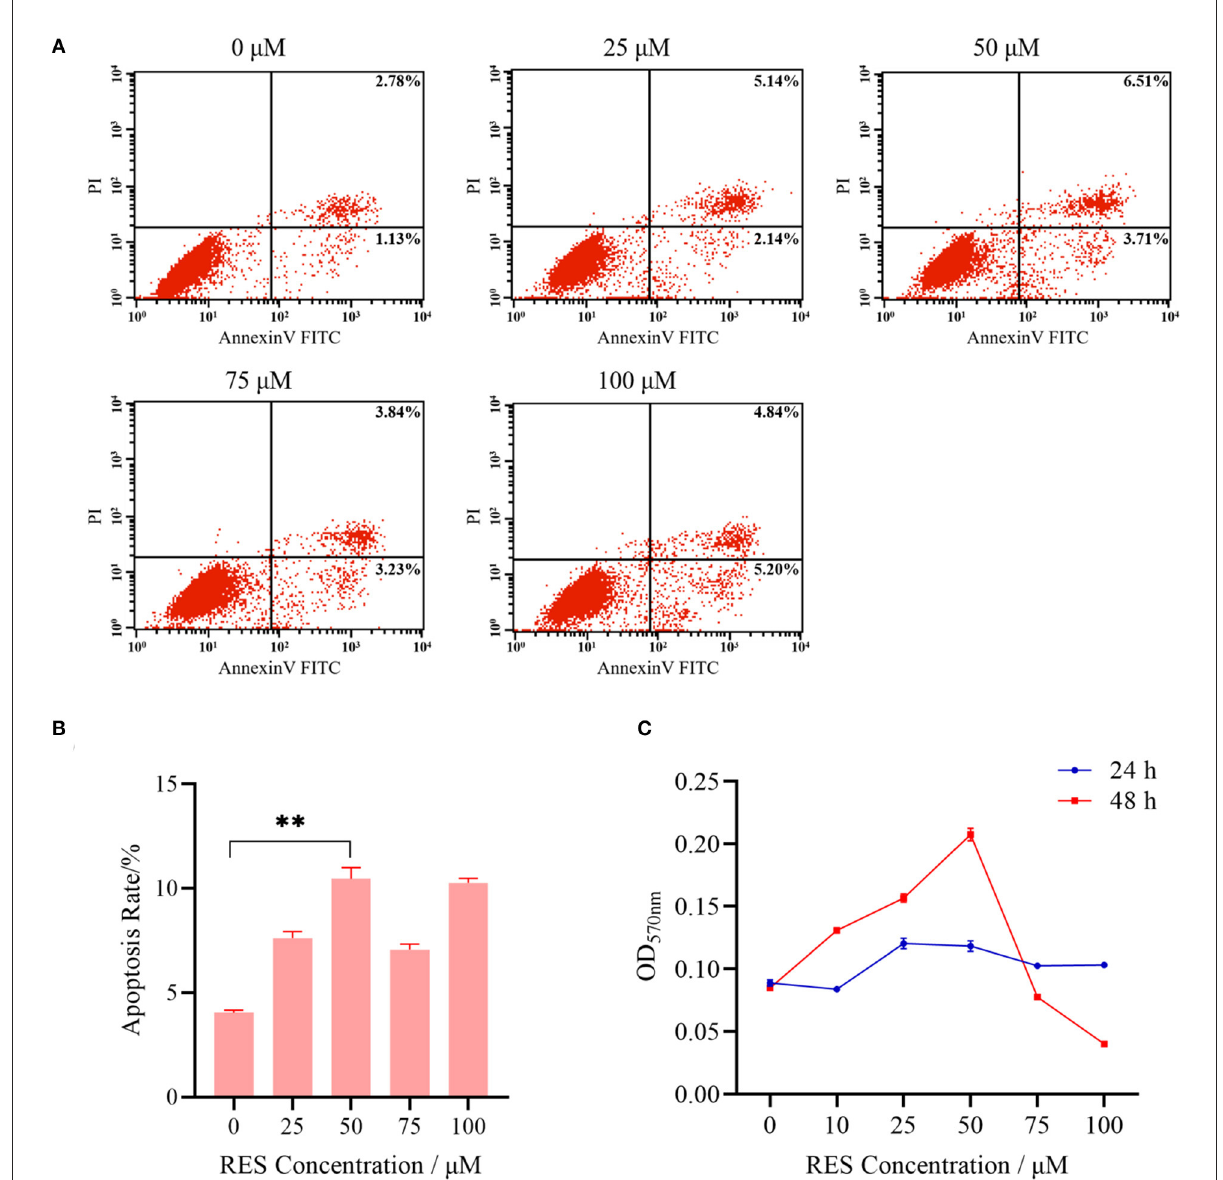
FIGURE2 Basic characteristics of POGCs models in different RES (0, 25, 50, 75, and 100 µ mol/L) groups. (A) Analysis of apoptosis level of POGCs receiving differing solutions of RES followed by Annexin V-FITC/PI kit and flow cytometry. (B) Apoptosis rate of POGCs in different RES concentration groups. (C) MTT assay was performed to assess the effect of RES on POGCs proliferation. ** P < 0.01.